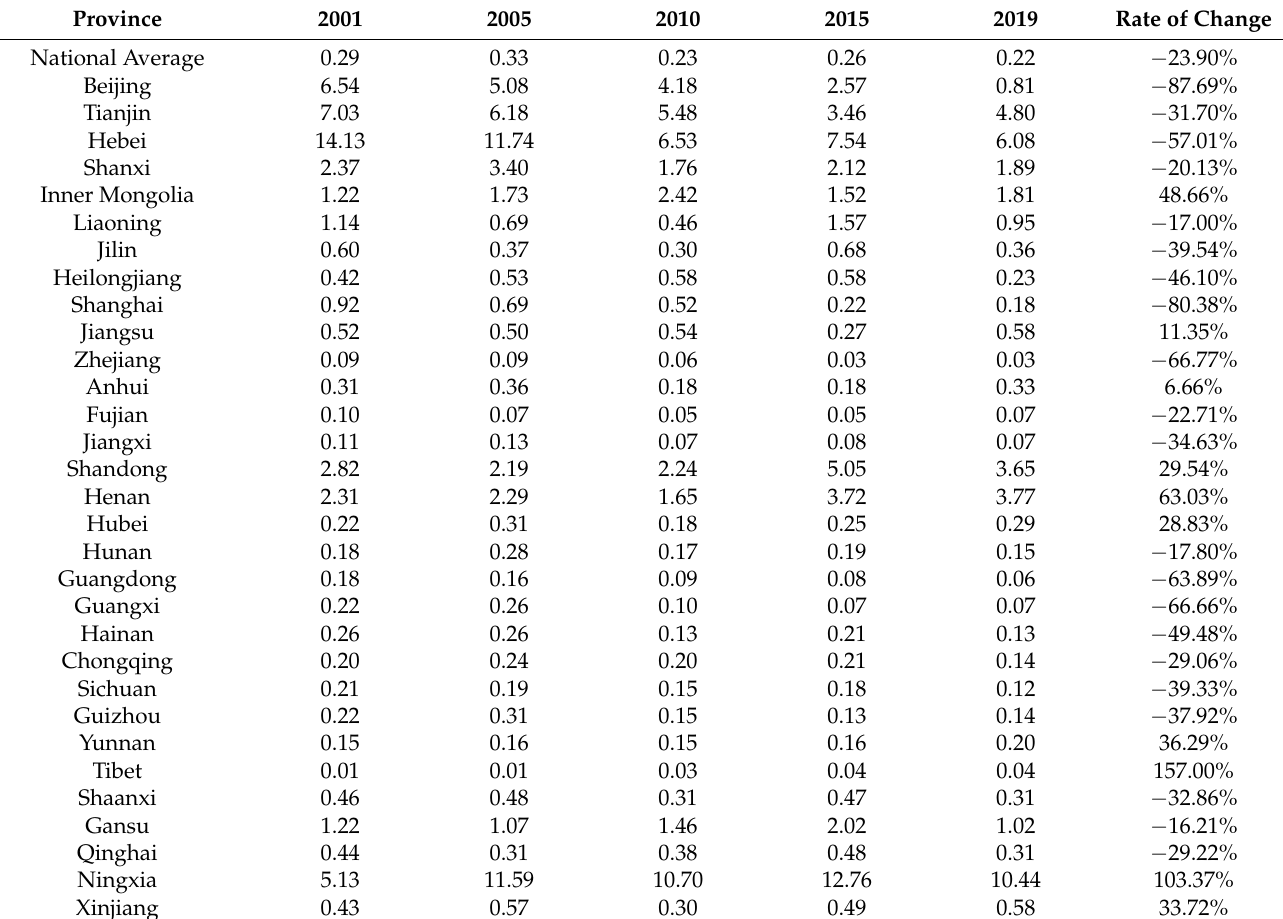
Table 5. Water environment bearing pressure and its change rate of animal husbandry in